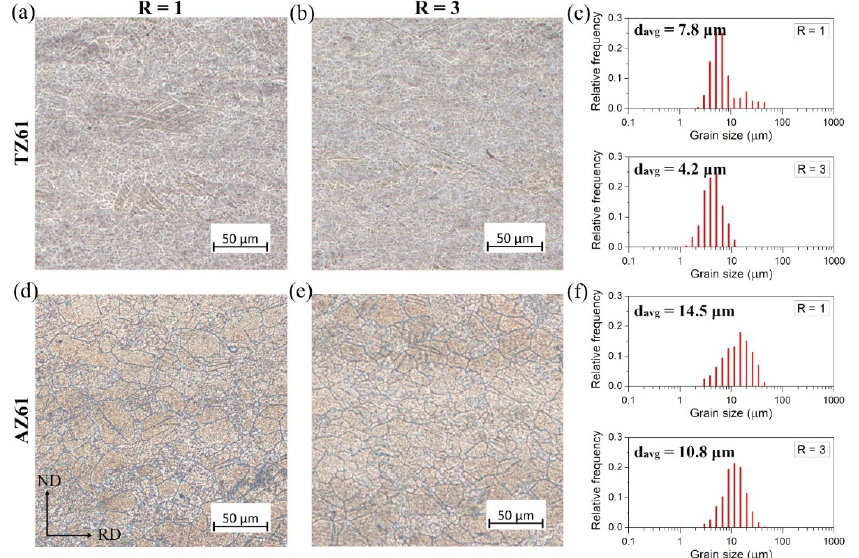
Figure 4. LM images of the microstructure and grain size distributions of the annealed ( a – c ) TZ61 and ( d – f ) AZ61 sheets processed at speed ratio of: ( a , c ) R = 1 and ( b , d ) R =